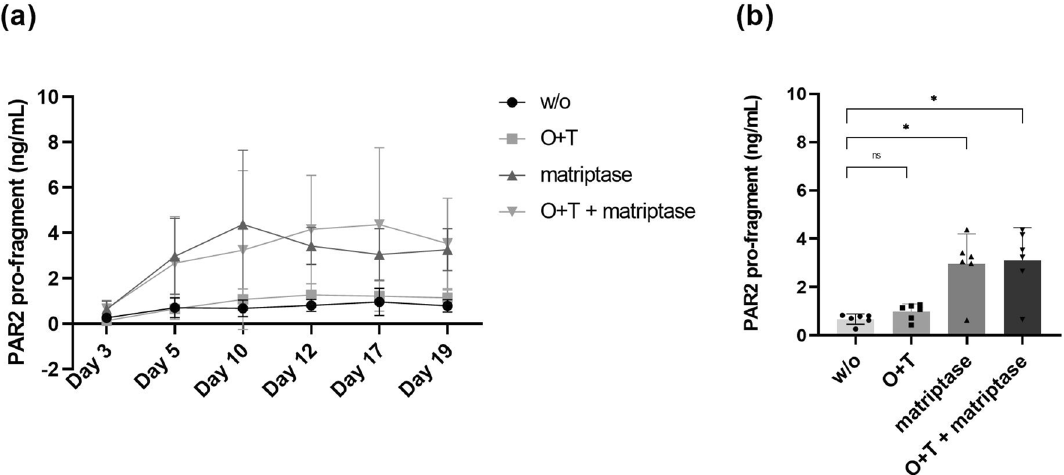
Figure 2. PRO-PAR2 release from human synovial explants (HEX). ( a ) PRO-PAR2 levels were measured in supernatant from the HEX model harvested on day 3, 5, 10, 12, 17 and 19. HEX cultures were either without treatment (w/o) or treated with matriptase and/or OSM + TNF-α (O + T). The release of the neo-epitope was quantified with the PAR2 immunoassay. ( b ) AUC analysis was performed to assess any statistically significant increase of PRO-PAR2 levels in matriptase-stimulated, (O + T)-stimulated as well as in matriptase + (O + T)-stimulated explants compared to the untreated explants. Group comparisons were done using Kruskal–Wallis test with Dunn’s post hoc for multiple comparisons. Data are presented as mean ± SD. Statistical significance is considered as * P < 0.05 and ns = P > 0.05.